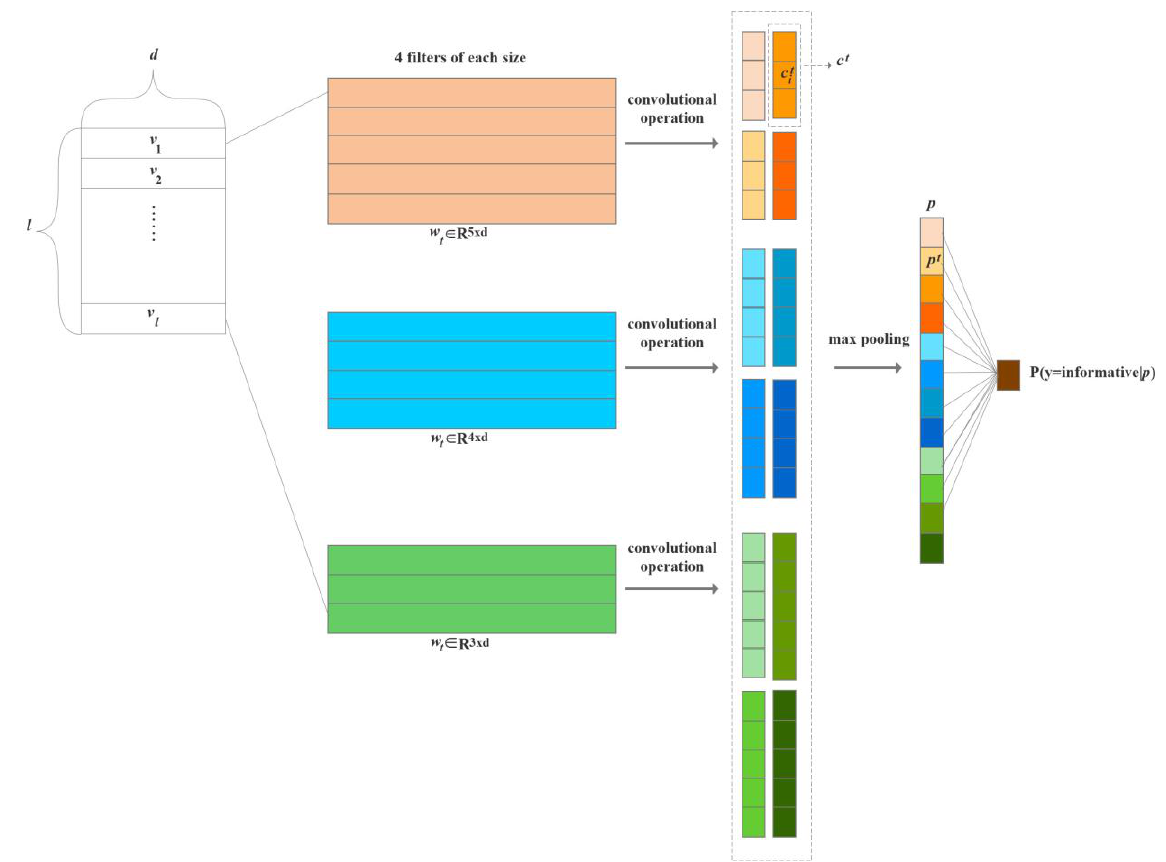
Figure 3. The structure of the CNN in this work.